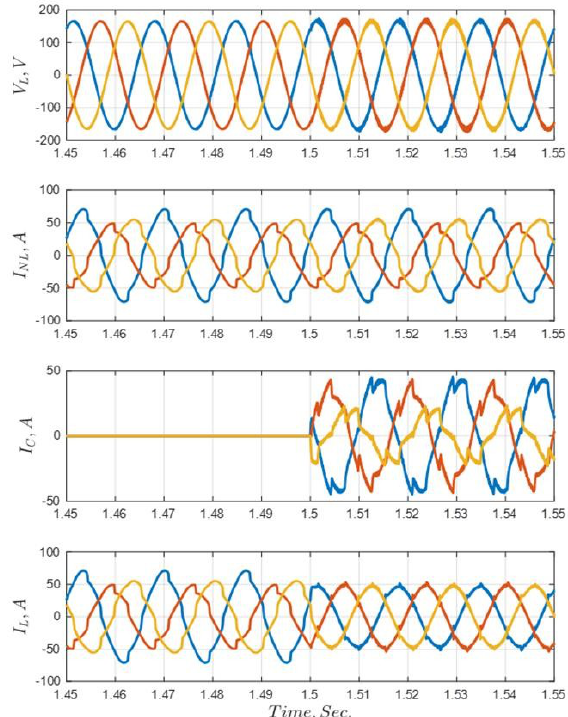
Figure 5. The three-phase voltage, load current, converter current, and bus current, respectively, at point of common coupling